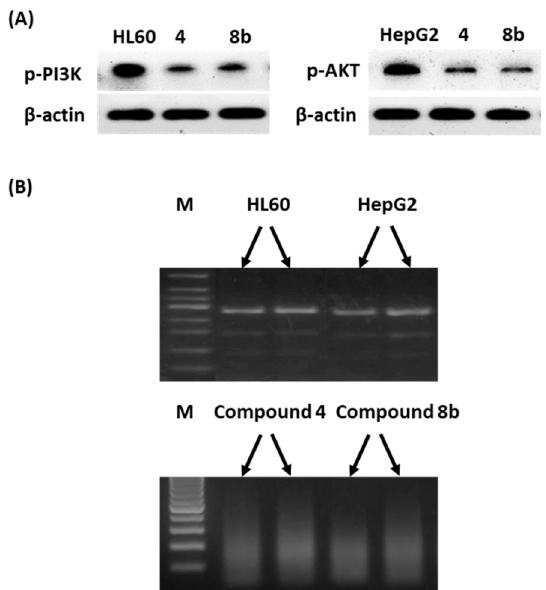
Figure 6. ( A ) Scanning densitometry Western blotting for p-PI3K and p-AKT proteins and ( B ) agarose gel electrophoresis DNA fragmentation for untreated and treated HL60 and HepG2 cells showing the loss of intact DNA fragments after exposure to compounds ( 4 ) and ( 8b ) (M refers to the DNA ladder). Results are duplicate.